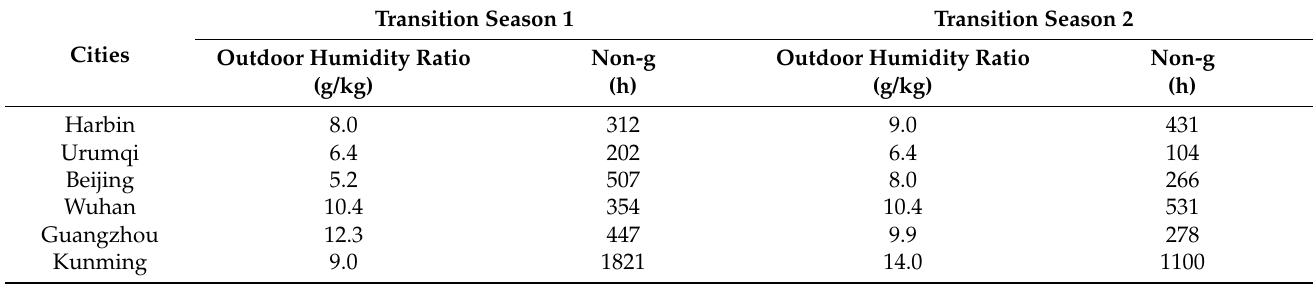
Table 6. Non-guaranteed hours of the outdoor humidity ratio in a transition season obtained by the V-C